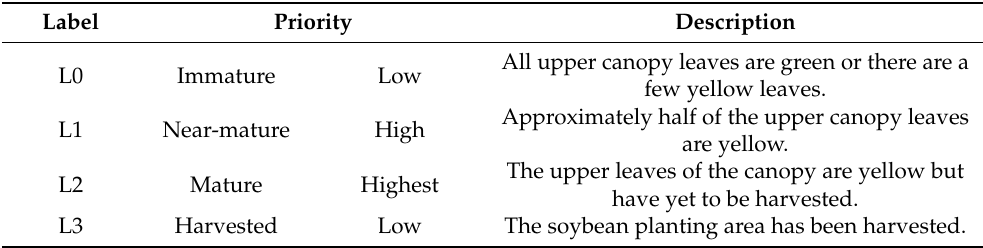
Table 2. Standards used for labeling the soybean plots.